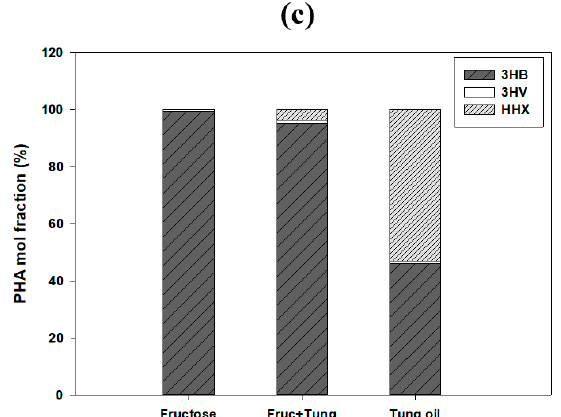
Figure 1. Effect of tung oil on ( a ) cell growth, ( b ) polyhydroxyalkanoate (PHA) production and ( c ) PHA mole fraction in R. eutropha 2133/pCB81. Statistical analysis was performed by applying ANOVA with the level of significance at 5%. 3HB, 3-hydroxybutyrate; 3HV, 3-hydroxyvalerate; DCW, dry cell weight; HHx, 3-hydroxyhexanoate; OD, optical density.